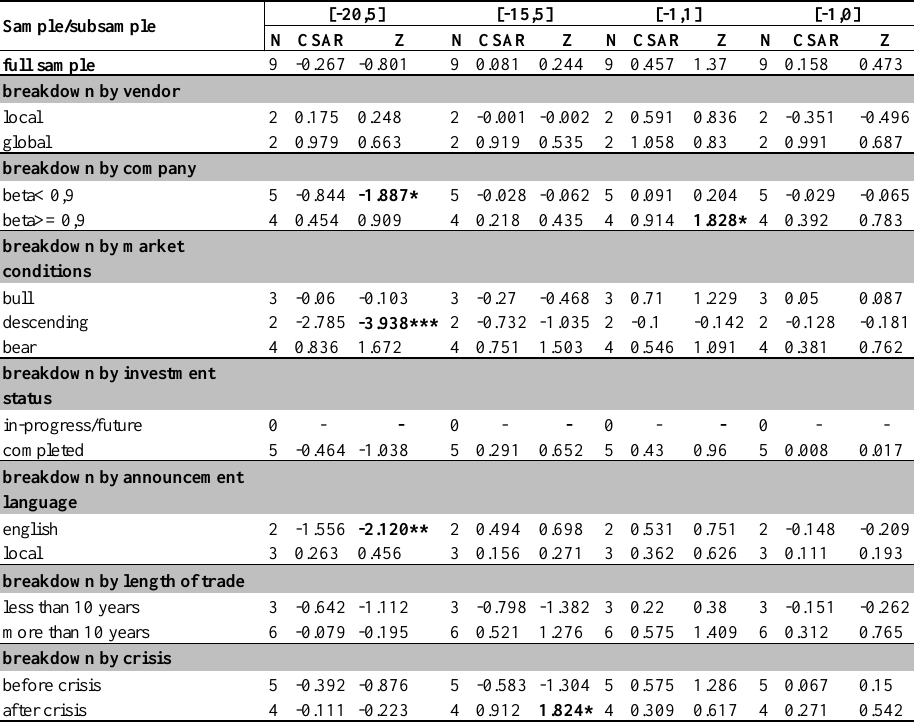
Table 3 – Summary of results from